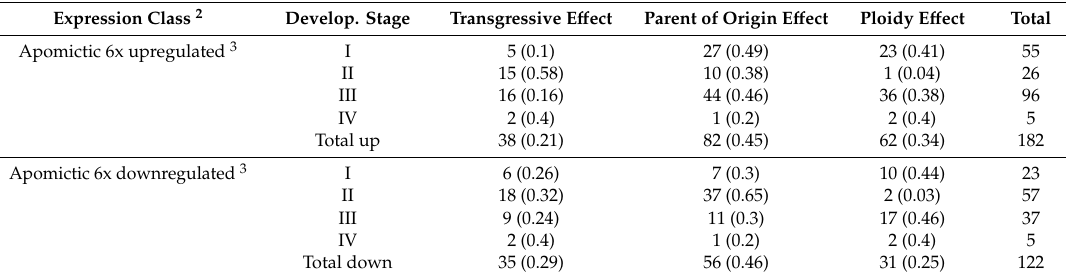
Table 3. Number of di ff erentially expressed genes 1 associated with each ovule developmental stage and expression class in diploid–polyploid comparisons (brackets show relative percentage compared to the overall stage number of